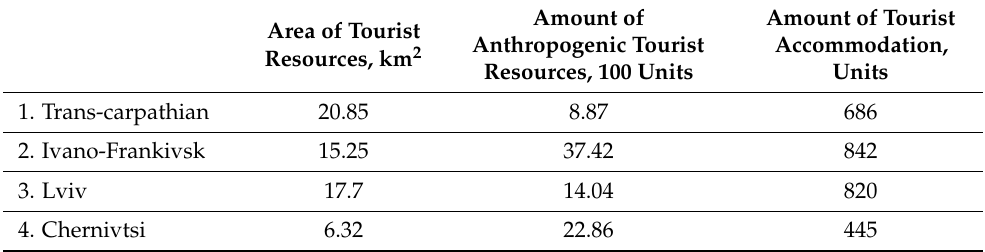
Table 3. Tourism potential of the administrative-territorial units of the Carpathian region.